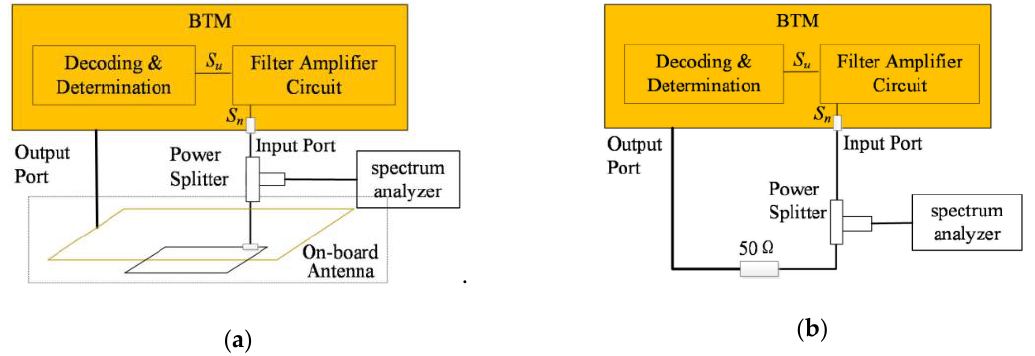
Figure 5. Setup to find out the main disturbance coupling path for BTM system: ( a ) The testing with the antenna connection; ( b ) The testing with 50 Ω connection.